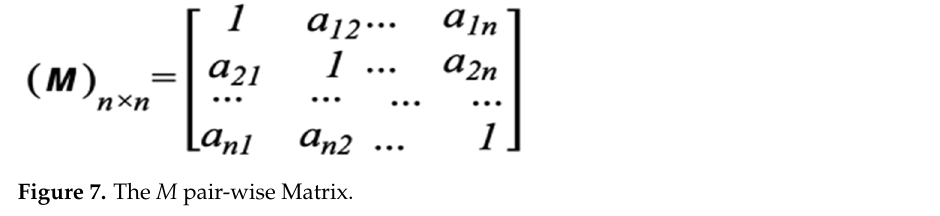
Figure 6. The Hierarchical GG with corresponding factors’ codes.